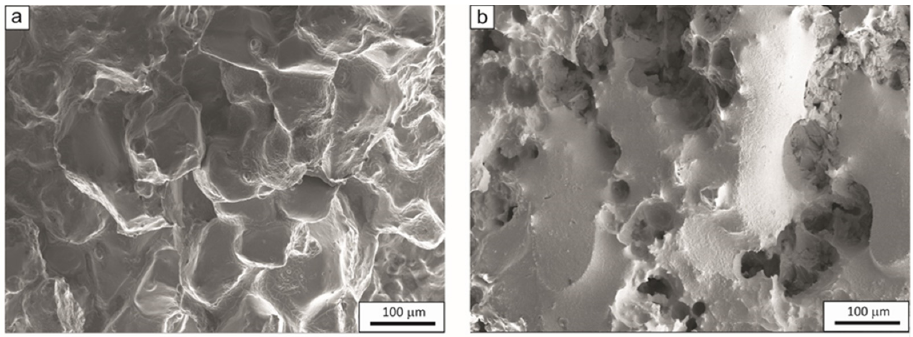
Figure 11. Fracture surfaces of samples of 27Mn-4Si-2Al-Nb steel after tensile test at temperatures NDT = 1235 °C ( a ) and DRT = 1220 °C ( b ).